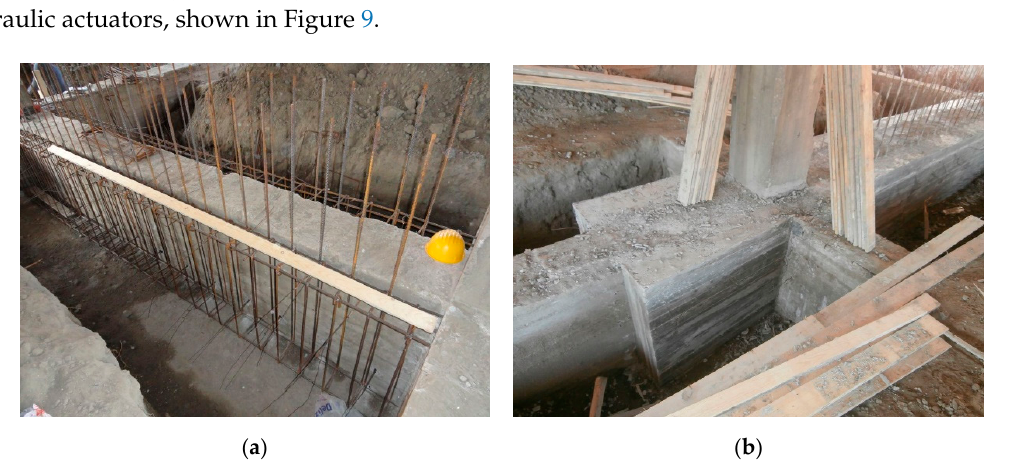
Figure 6. Footings retrofit: Steel reinforcement ( a ) and section enlargement ( b ).